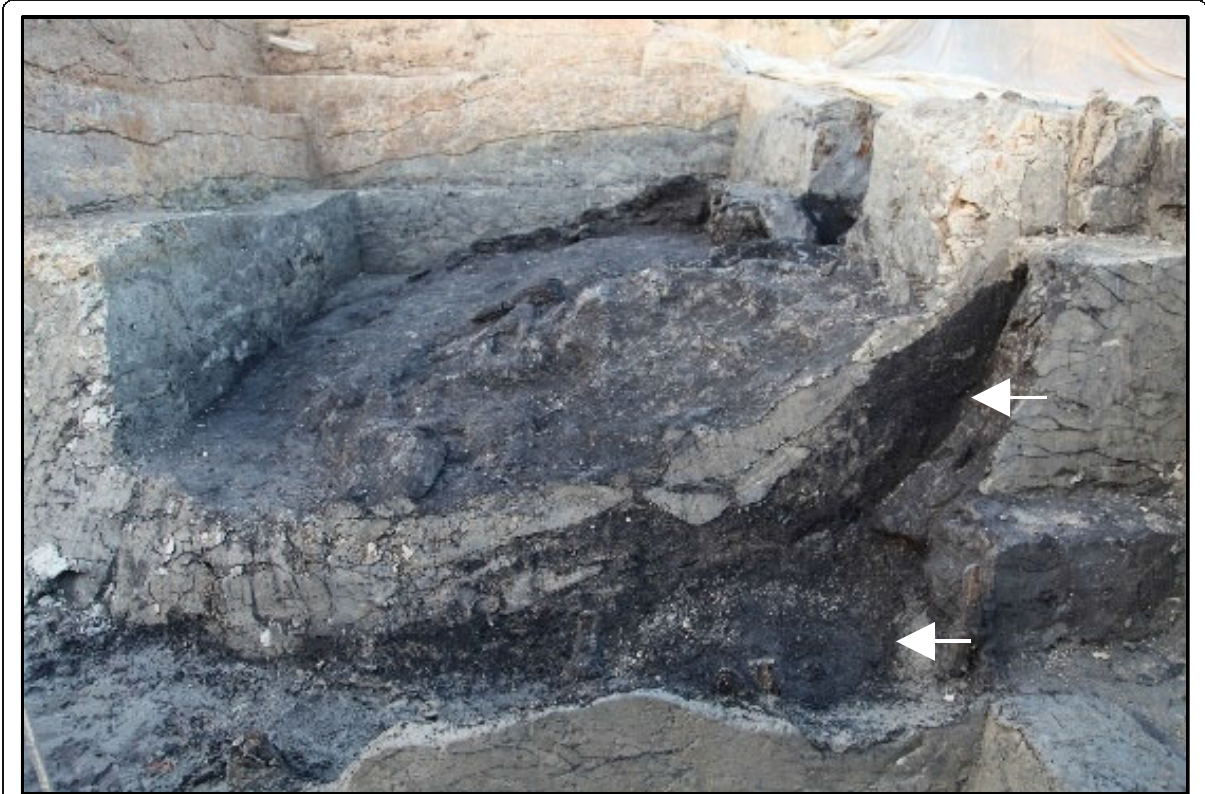
Fig. 1 The excavated site of archaic rice in the Mojiaoshan site. White arrows indicate layers of archaic rice